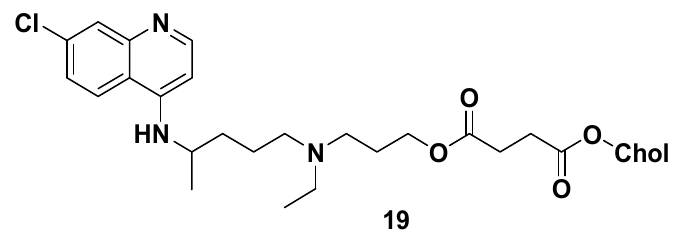
Figure 8. Cholesterol-modified HCQ ( 19 ).